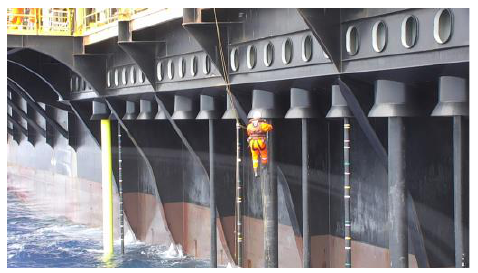
Figure 1. Riser inspection by industrial climber.